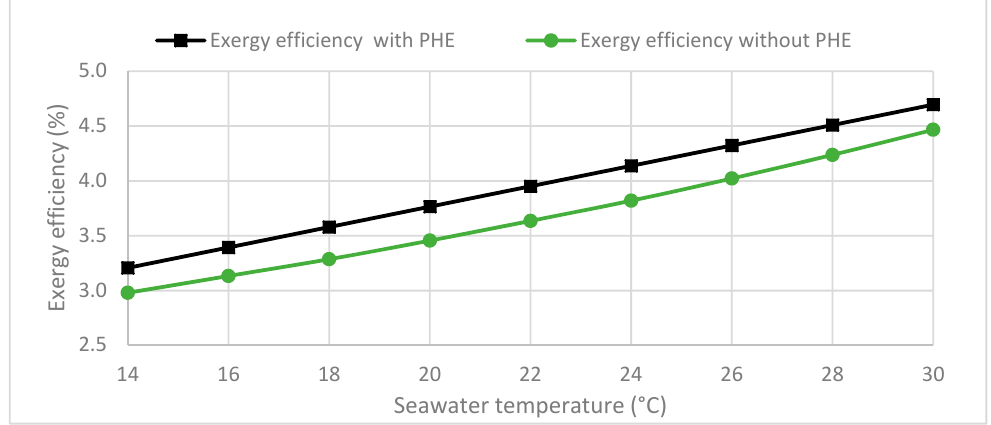
Figure 2. Exergy efficiency for both systems versus seawater temperature, with and without preheating.